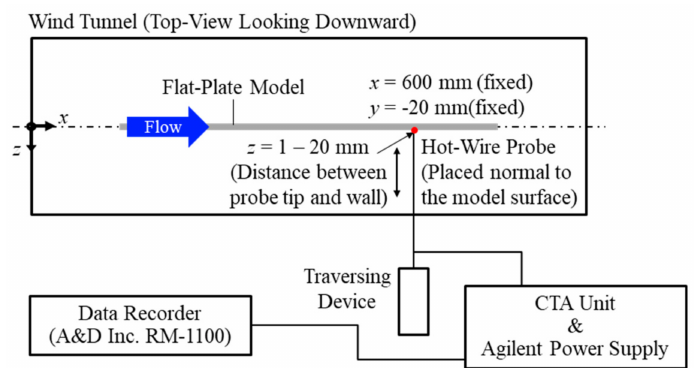
Figure 2. Schematic diagram of hot-wire anemometry setup and measurement